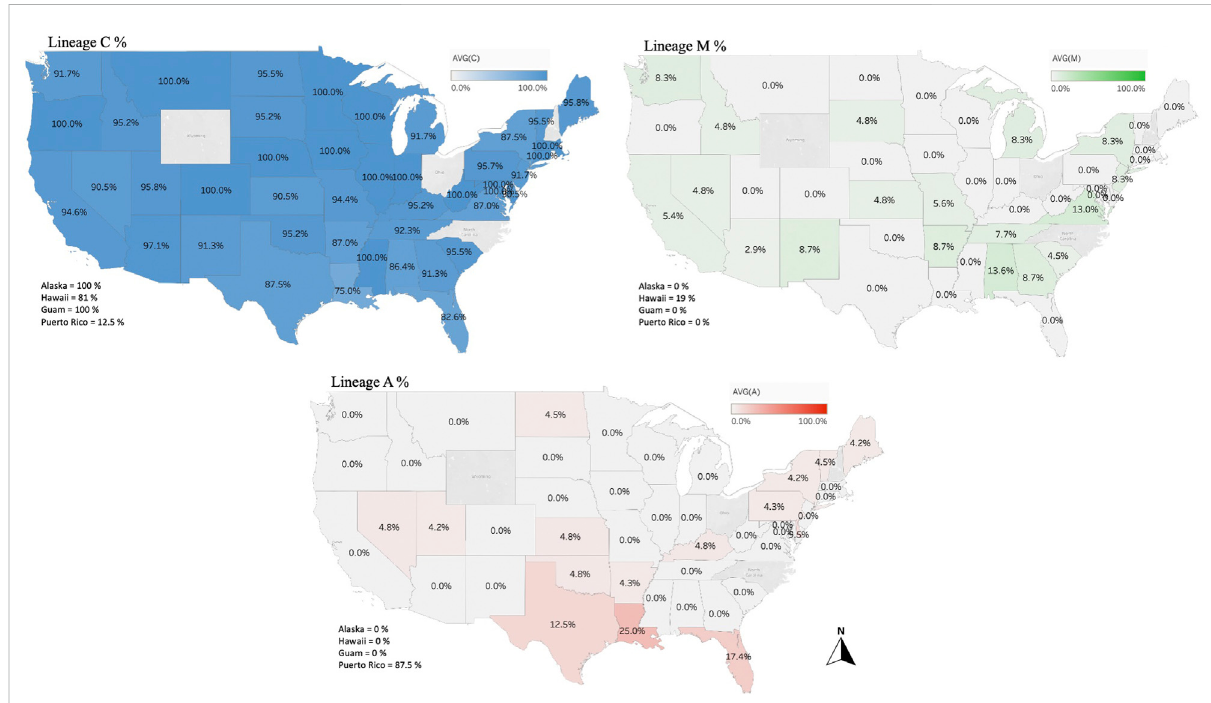
FIGURE 3 Percentagesofthethreeidenti fi edmaternallineages(NorthMediterraneanC,WestMediterraneanMandAfricanlineageA)intheUShoneybee populations computed and displayed by states and territories. Samples from the States of OH, NC, NH, WY and RI were not